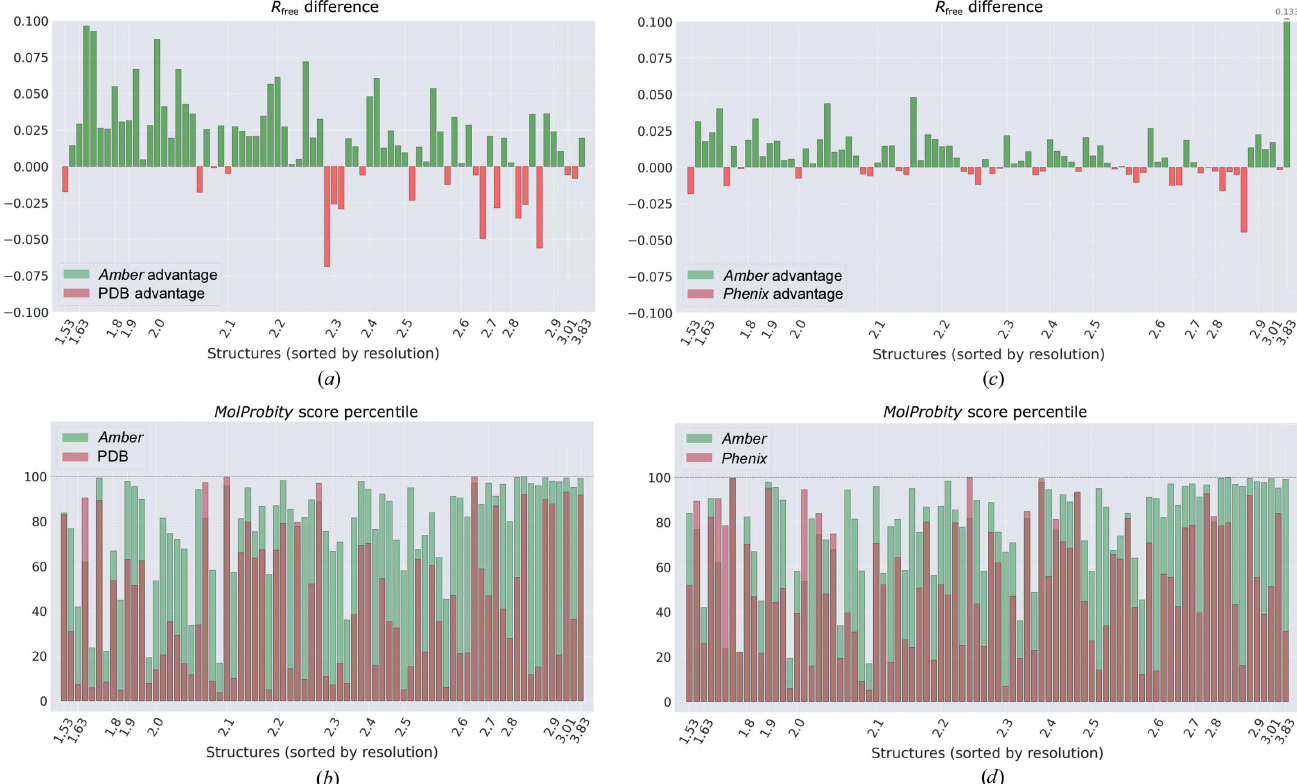
Figure 6 Summary of the refinement results starting from the deposited models (D-models). All data shown in these graphs are also tabulated in Supplementary Table S3. Plotting conventions are the same as in Fig.